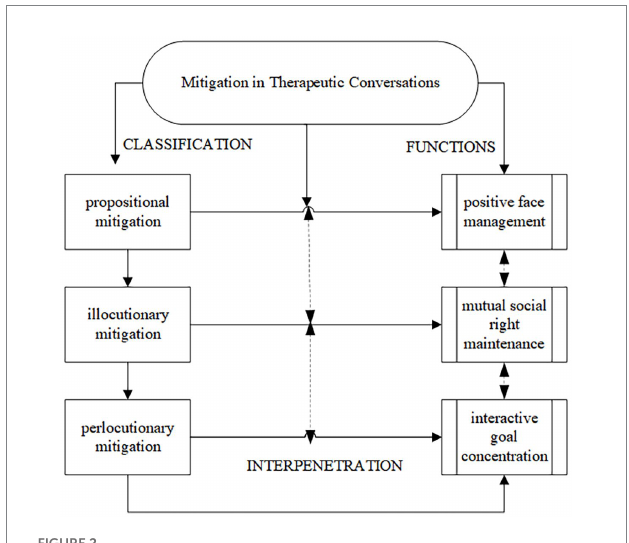
FIGURE 2 Interpenetration of the cognitive-pragmatic functions of mitigation in therapeutic